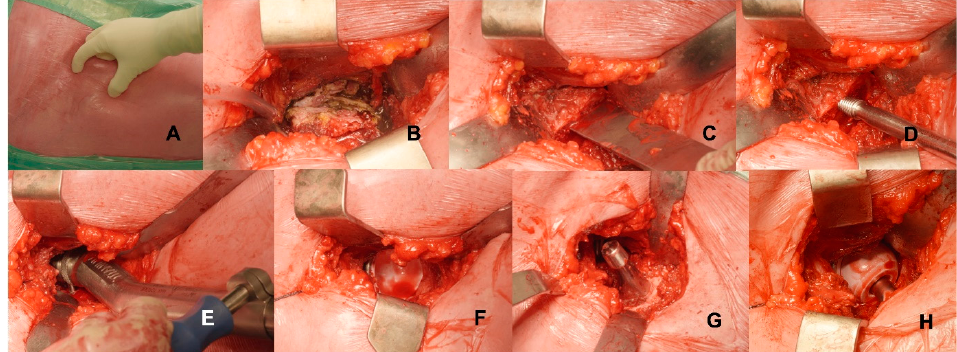
Figure 3. ( A ) DAA incision is performed 2 cm distally and 2 cm laterally from the anterior superior iliac spine; ( B ) through the intermuscular space between the tensor fascia latae and sartorious and rectus femoris muscles, the capsula is completely exposed. ( C ) Neck osteotomy is performed with